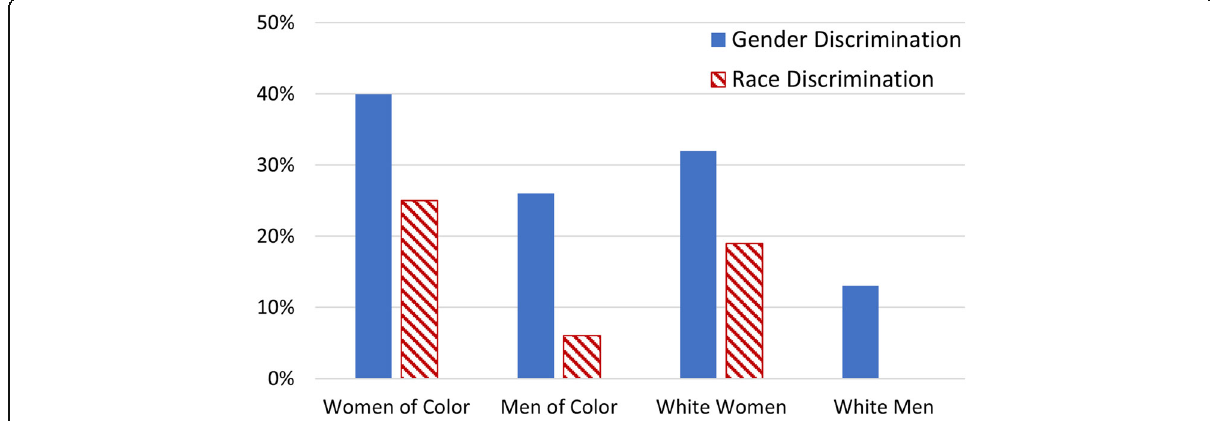
Fig. 5 Percent who mentioned likely impacts related to discrimination against women and students of color, by respondents ’ gender-by-race